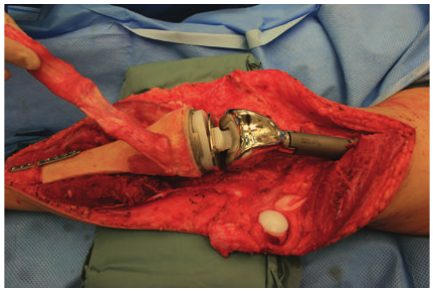
Figure 3: Wrapping of megaprosthesis.